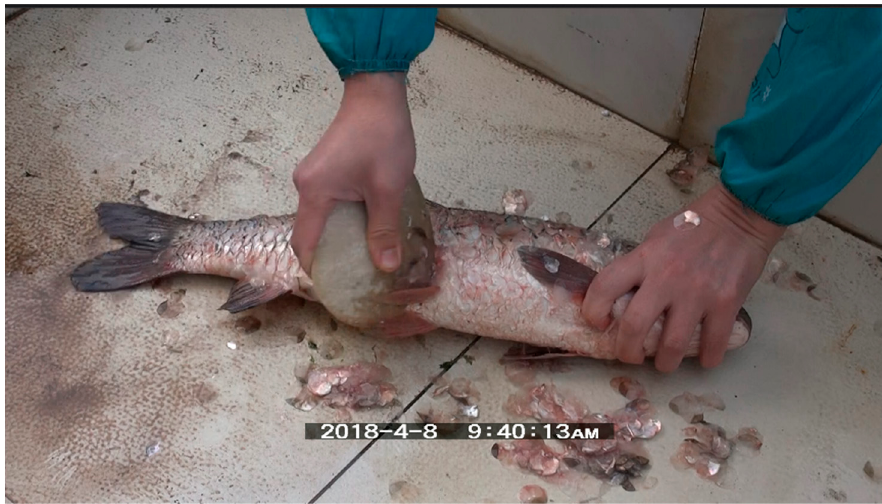
Figure 10. RHBF flake used for fish scaling.